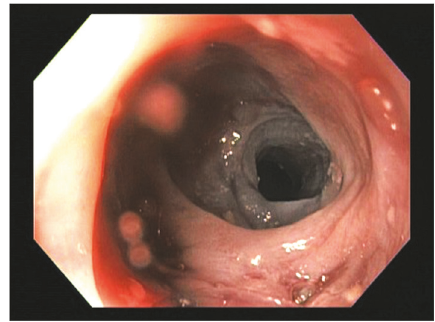
Figure 4: Esophageal squamous epithelium with H&E staining at 100x magnification. Findings showing lymphocytic infiltrate in the basal layer and scattered apoptotic keratinocytes (Civatte bodies).